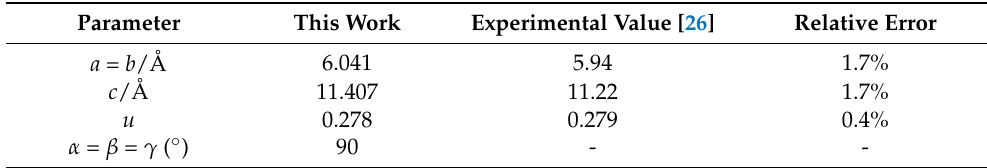
Table 1. The structural optimization results of CdGeAs 2.